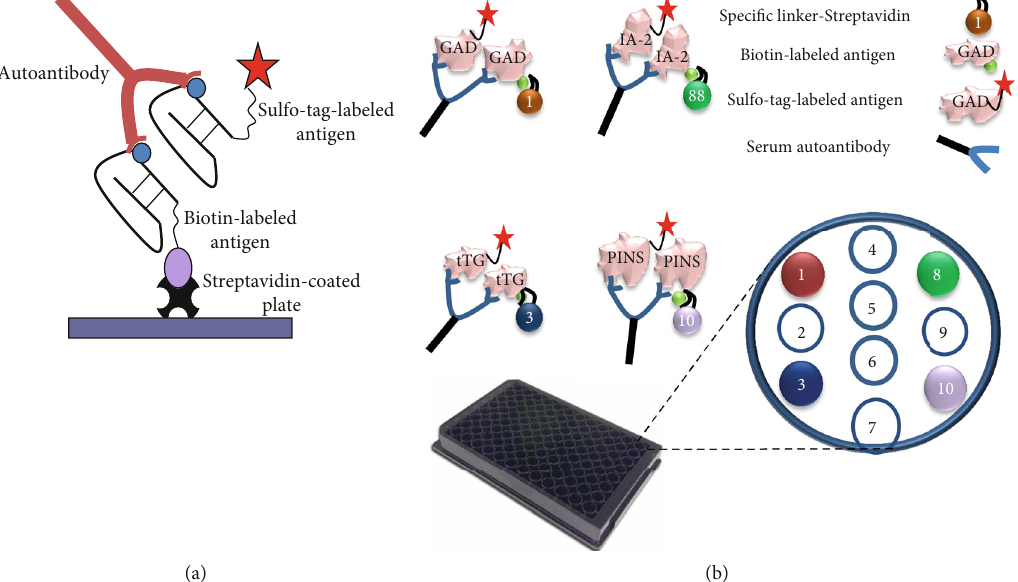
Figure 1: Illustration of ECL assay. (a) Single autoantibody ECL assay. The autoantibodies in serum bridge the sulfo-tagged antigen to the biotinylated antigen which will be captured by the streptavidin-coated plate. Detection of plate captured sulfo-tagged antigen is accomplished with ECL. (b) Multiplex autoantibody ECL assay. The autoantibodies in serum bridge the sulfo-tagged antigen to the biotinylated antigen which is coupled with a streptavidin-attached speci fi c linker. Each speci fi c linker coupled antibody-antigen complex will be limited in a designated spot area of each well. Detection of plate captured sulfo-tagged antigens is accomplished with